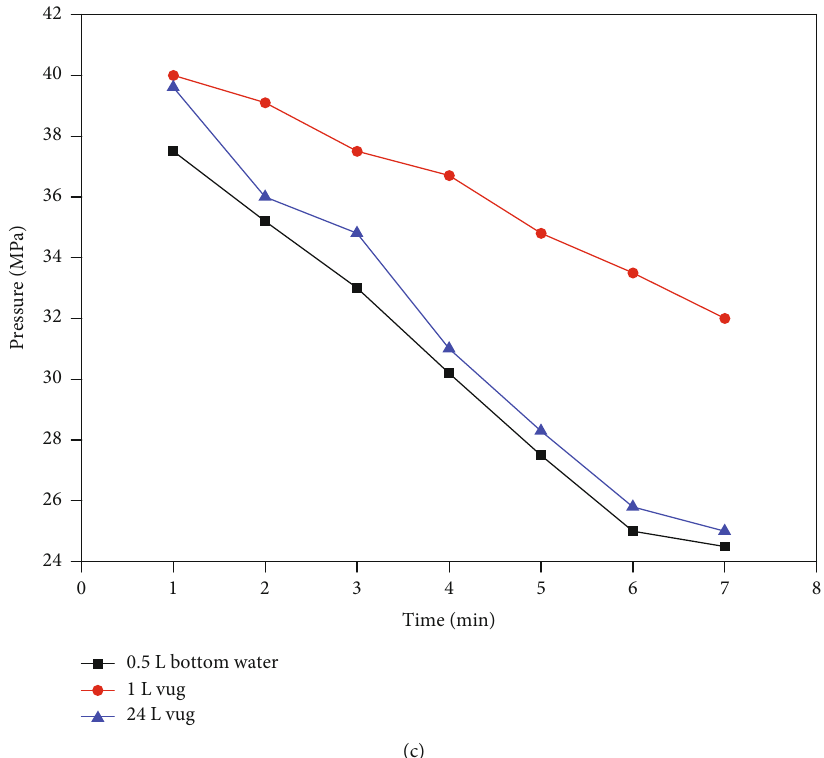
Figure 8: Pressure variation curves in high-pressure physical property experiments under connection type II (di ff erent production rates with (a) 1 mL/min, (b) 10mL/min, and (c) 30